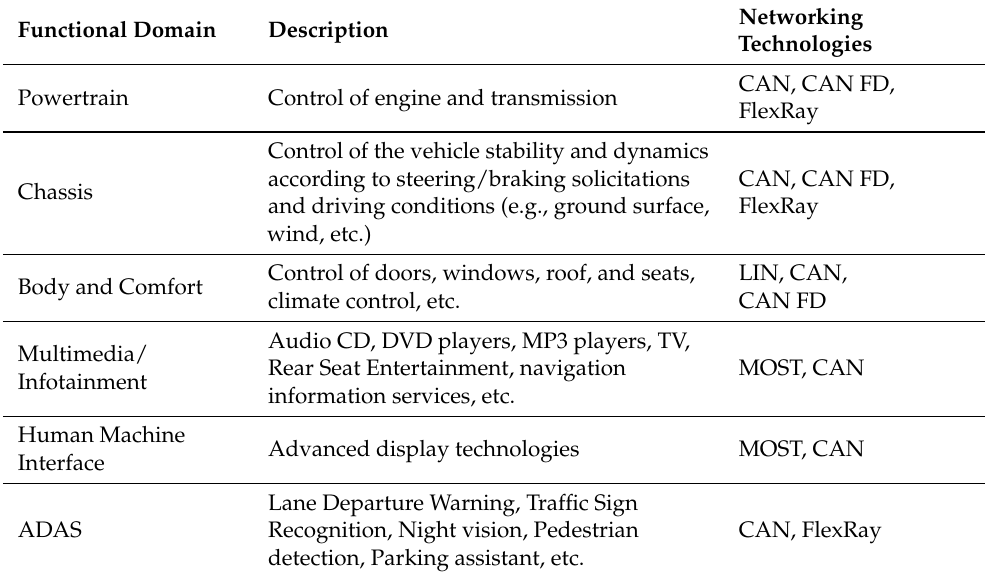
Table 1. The traditional automotive functional domains. Functional Domain Description